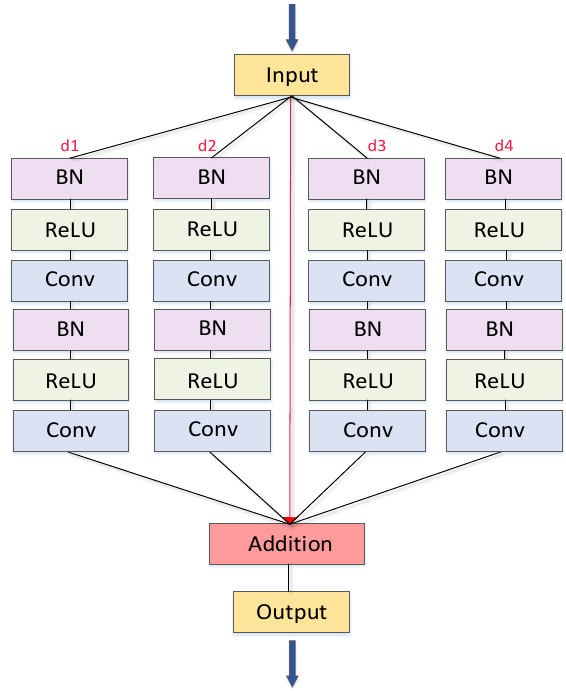
Figure 3. Structure of the Resblock module.